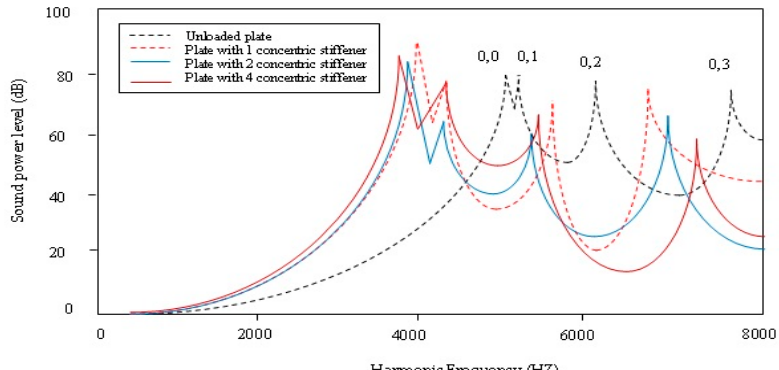
Figure 20. Numerical comparison of sound power level for annular plate having parabolic decreasing increasing thickness variations (Case II) for different combinations of concentric stiffener patches for taper ratio T x = 0.75. Appl. Sci. 2018 , 8 , x FOR PEER REVIEW 24 of 33